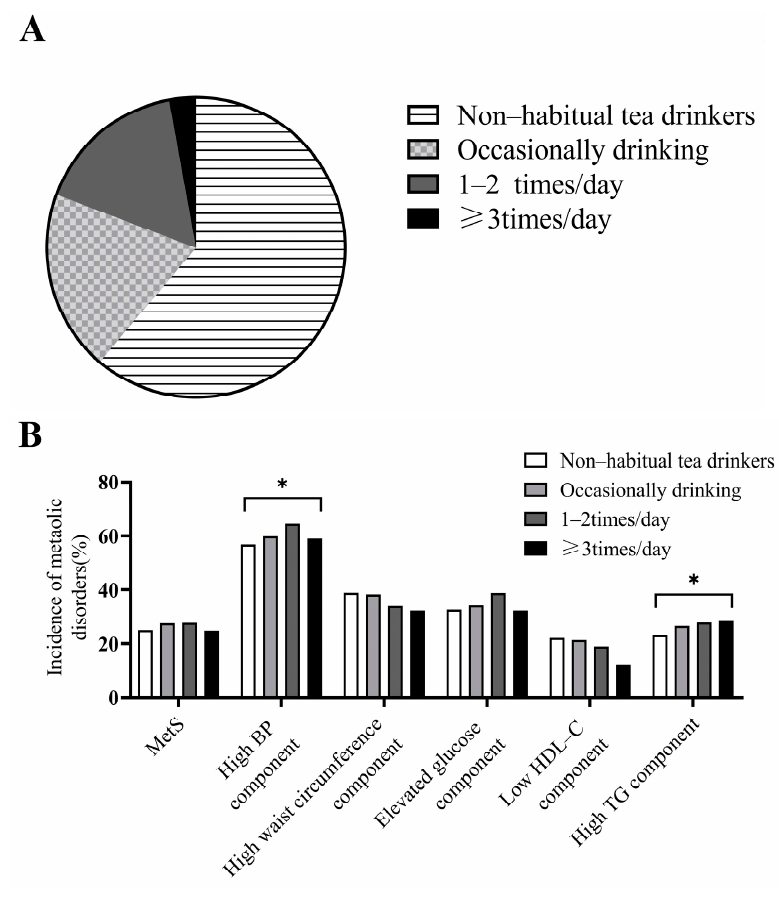
Figure 1. Prevalence of different frequency of tea consumption among study subjects and the cumulative incidence of metabolic disorders and metabolic syndrome in different tea consumption groups. * means p < 0.05 between groups. MetS: metabolic syndrome; BP: blood pressure; HDL-C: high density lipoprotein cholesterol; TG: triglyceride.